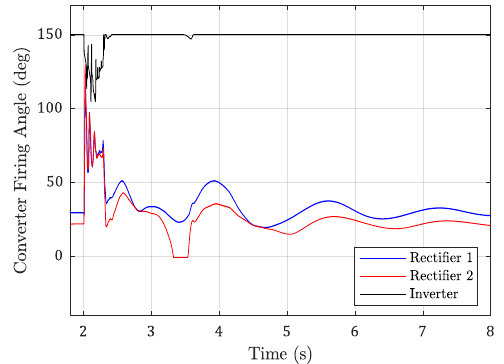
Figure 14. Firing angle in deg.